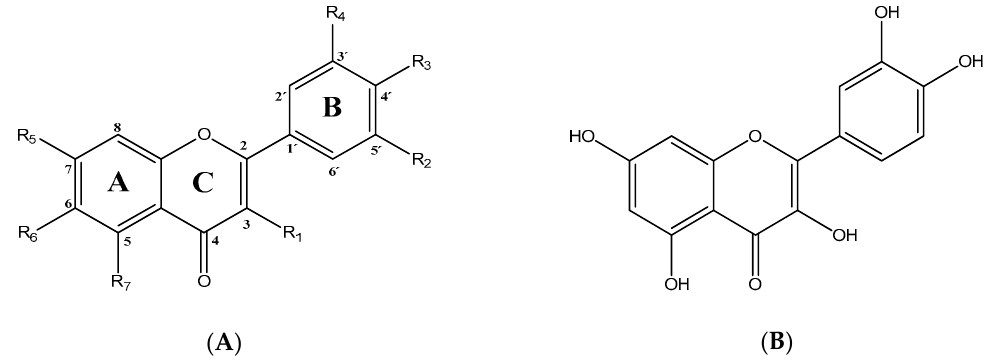
Figure 1. Chemical structures of: ( A ) flavone backbone with potential substituent sites; ( B ) QCT.